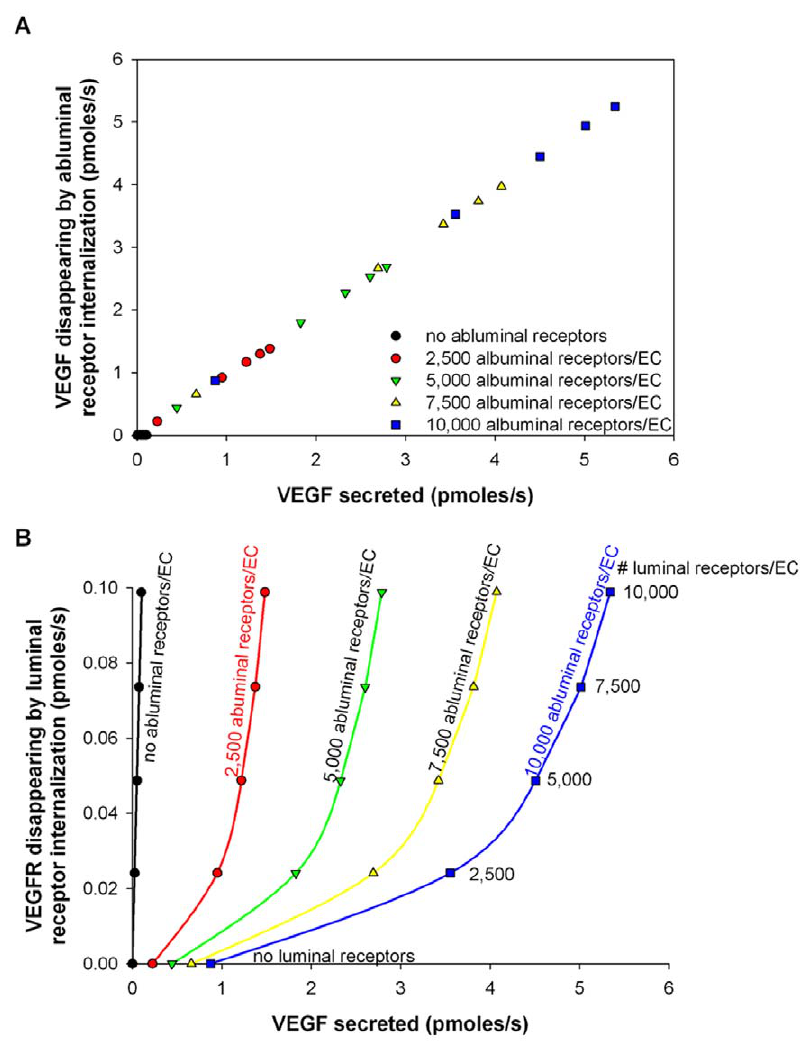
Figure 5. Flows of VEGF disappearing upon ligated receptor internalization as a function of the VEGF secreted. The setup is similar to that in Figure 4. A. Linear relationship between the VEGF secreted and the VEGF disappearing via internalization of VEGF-bound abluminal receptors. B. Non-linear relationship between the VEGF secreted and the VEGF disappearing via internalization of the luminal receptors it has bound to. Black circles: no abluminal receptors; red circles: 2,500 abluminal receptors/endothelial cell; green triangles: 5,000 abluminal receptors/endothelial cell; yellow triangles: 7,500 abluminal receptors/endothelial cell; blue squares: 10,000 abluminal receptors/endothelial cell.